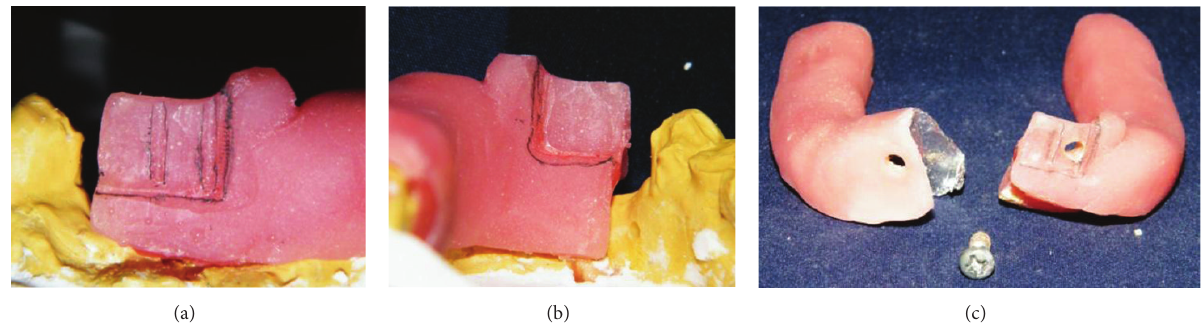
Figure 2: Fabrication technique for the sectional tray—Design